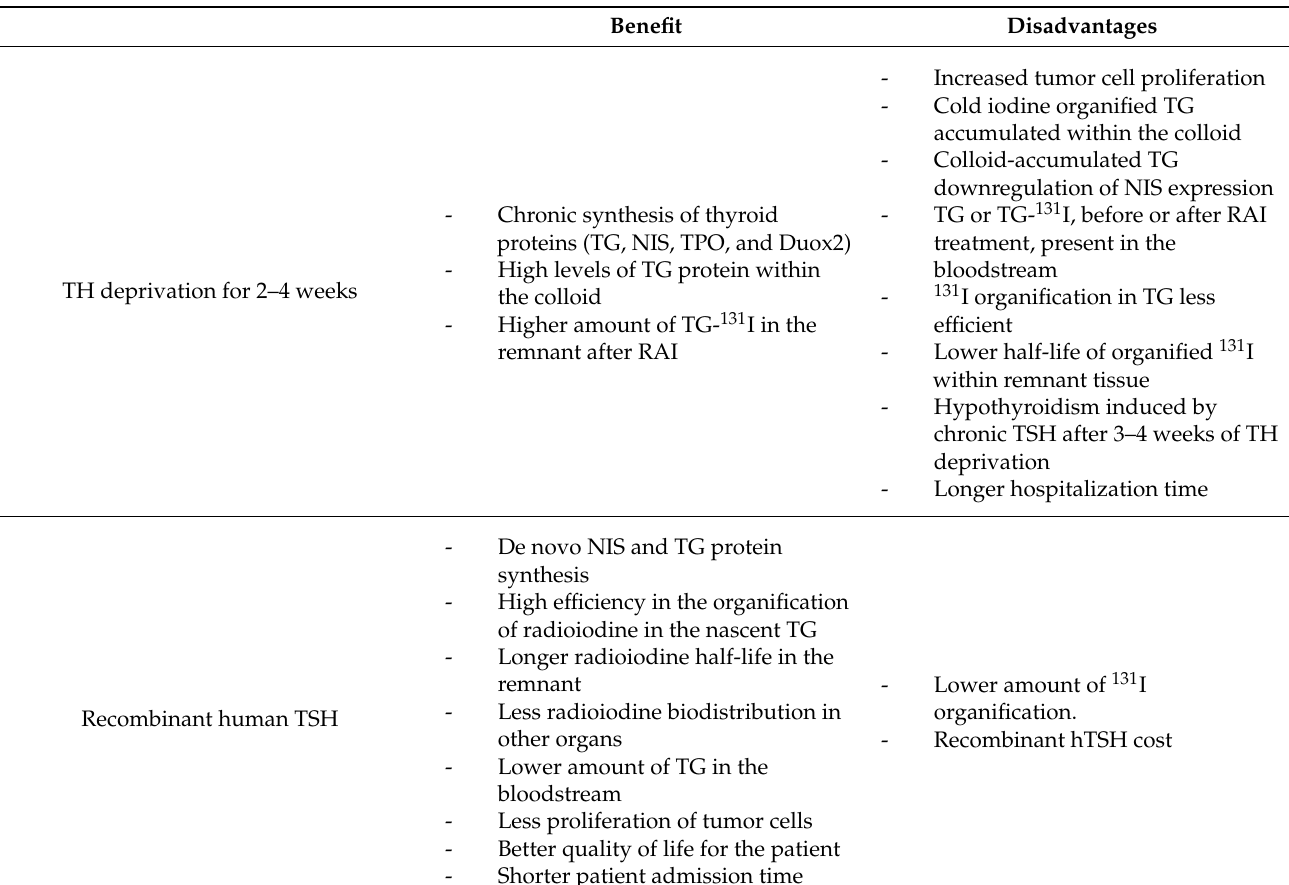
Table 4. Main benefits and disadvantages in the use of TH deprivation vs. stimulation with recombinant human TSH before RAI